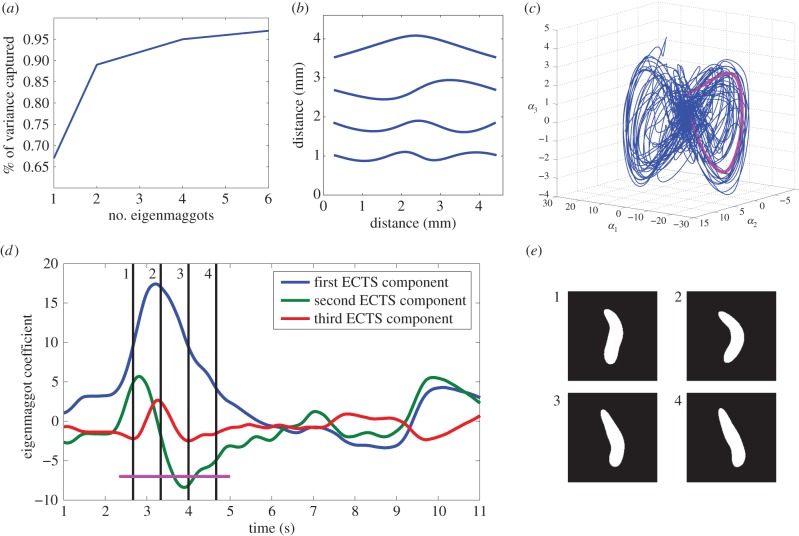
Results of eigenmaggot analysis. Panel (a) shows the percentage of the original data's variance recovered given the dimensionality of the representation. Panel (b) shows the eigenmaggots with the most significant eigenmaggot on top, the second below, etc. These shapes can be added up in different proportions to reproduce the larval postures (figure 1). Panel (c) shows a three-dimensional behavioural trajectory in eigenmaggot space, that is the time evolution of the first three eigenmaggot coefficients. The subtrajectory highlighted is an example of what we call a turning manoeuvre, see §3.2. Panel (d) shows a part of the same trajectory as three separate one-dimensional time series; the subsequence underlined corresponds to the highlighted subtrajectory on panel (c). Panel (e) shows binary images of the maggot at the corresponding time slices from panel (d).